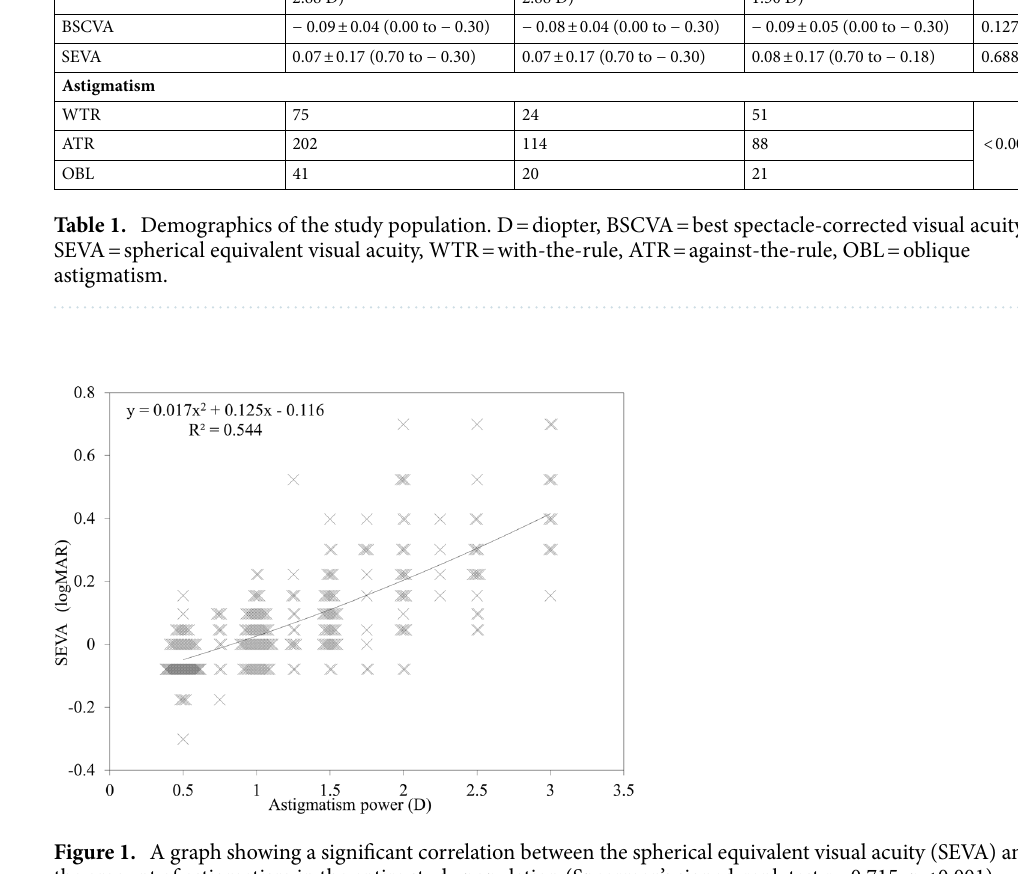
Table 2 summarizes the outcomes of estimating distance visual acuity according to the amount of astigmatism, based on the above regression formulas: y = 0.028x 2 + 0.104x − 0.100 (R 2 = 0.587) for pseudophakic subjects, and